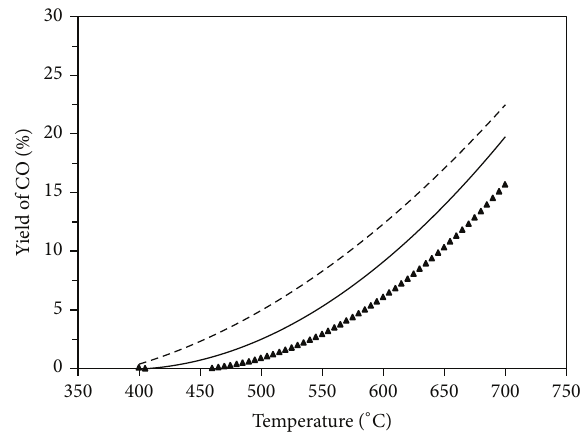
Figure 11: Average yield of CO for the reverse water gas shift = 𝑃 = 1 kPa, balance He, GHSV reaction at 1atm, 𝑃 H 2 CO 2 = 176000 h −1 , and 50 mg of Cu 𝑥 Ni 1−𝑥 /C catalyst: The solid line represents Cu 20 Ni 80 /C catalysts, the triangles represent Cu 50 Ni 50 /C catalysts, and the dashed line represents Cu 80 Ni 20 /C catalysts.